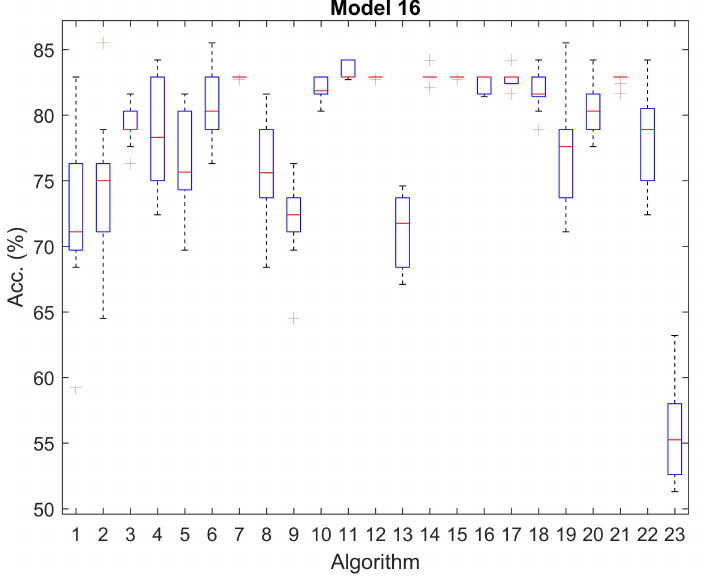
Figure 8. Accuracy of Model 16 for the different algorithms. The 23 algorithms are represented in the x -axis, and the accuracy is shown in the y